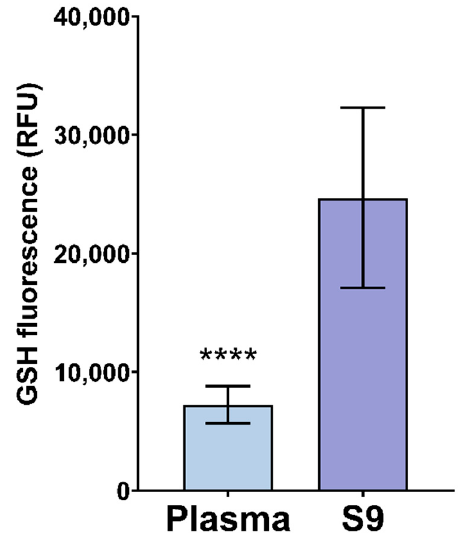
Figure 5. Relative fluorescence (RFU) of reduced glutathione (GSH) in plasma and S9 of white stork ( C. ciconia ) nestlings ( n = 16), presented as the mean ± SD. Statistical difference is indicated with **** (Welch’s t-test, p < 0.0001).